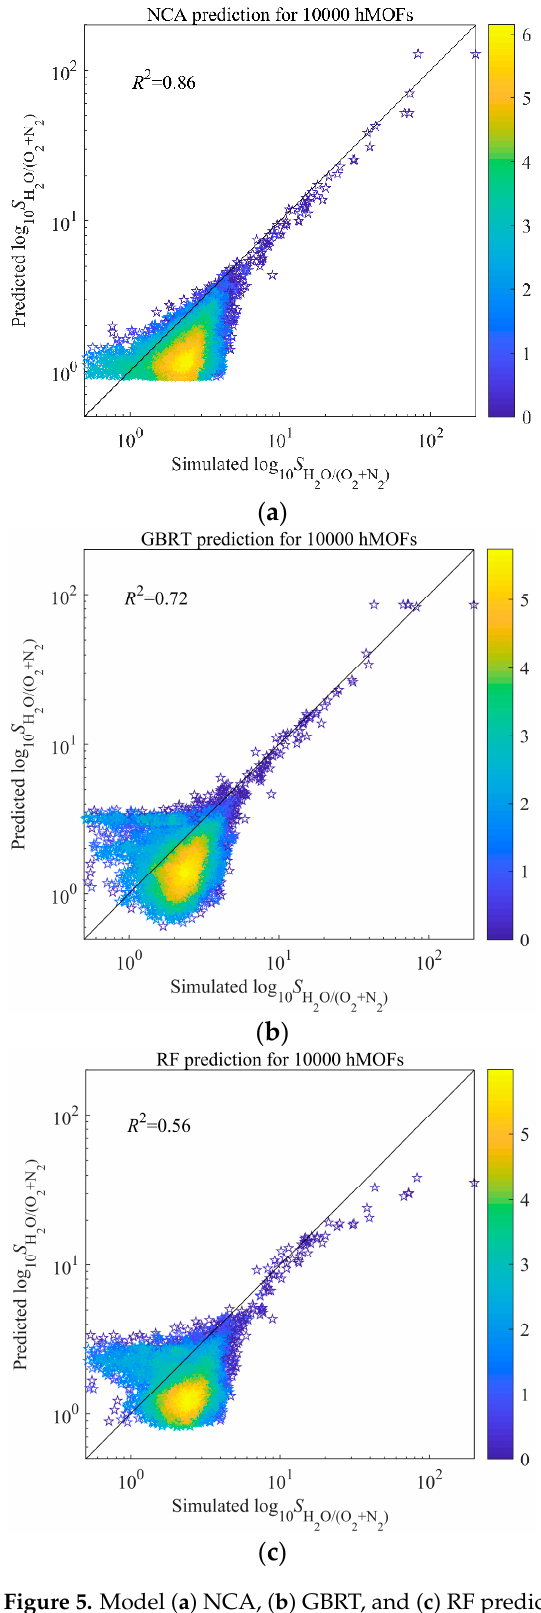
Figure 5. Model ( a ) NCA, ( b ) GBRT, and ( c ) RF prediction for 10,000 hMOFs. The color represents a base- e logarithm of the number of MOFs.